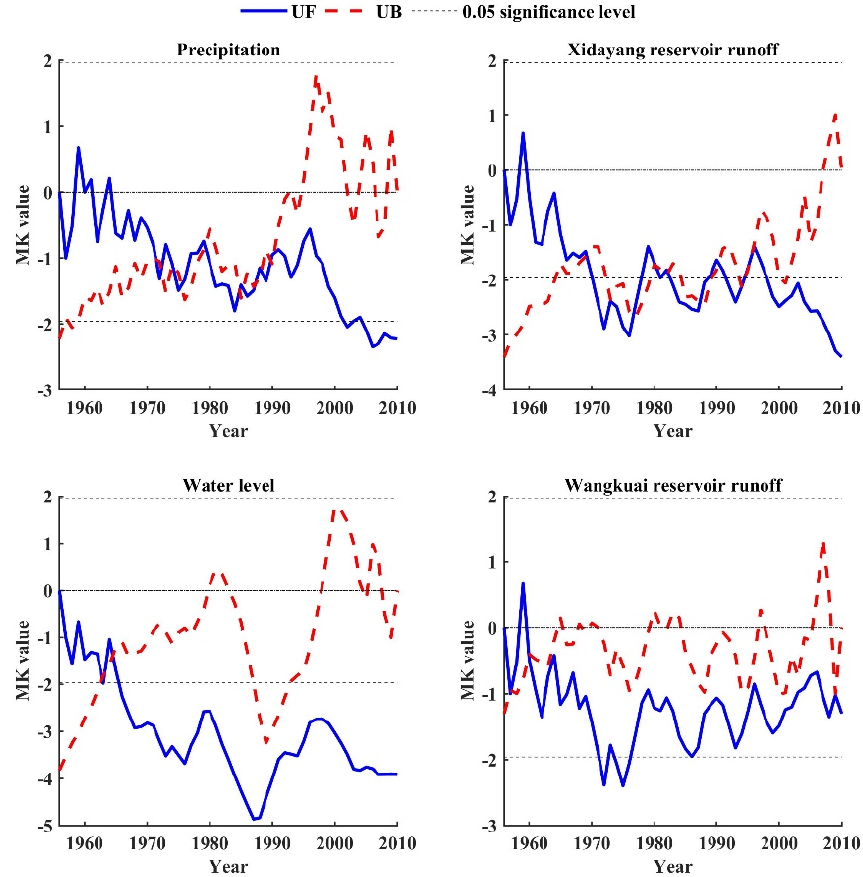
Figure 6. The MK (Mann–Kendall) test results for precipitation, runoff, and water level.